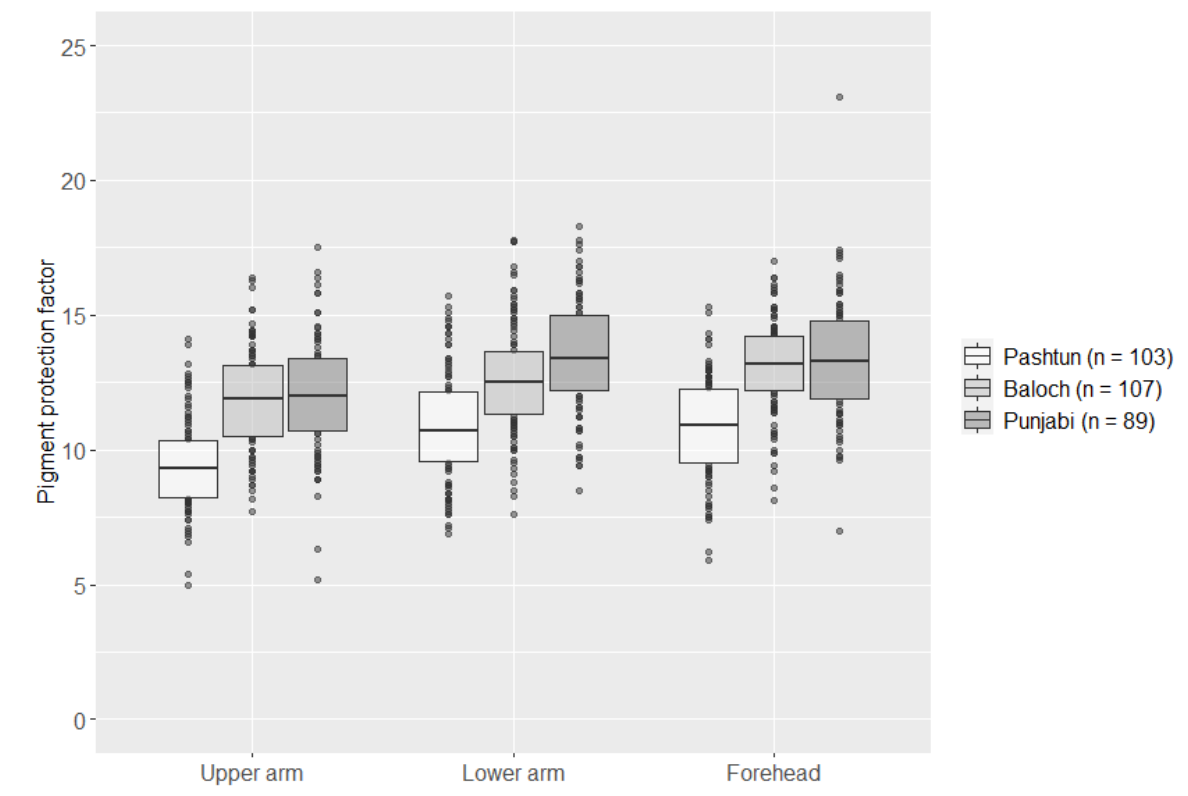
Figure 1. Boxplots of skin pigmentation measurements (pigment protection factor) of the upper arm, lower arm, and forehead in three Pakistani subpopulations. The pigment protection factor was measured in triplicate at each measured skin area.